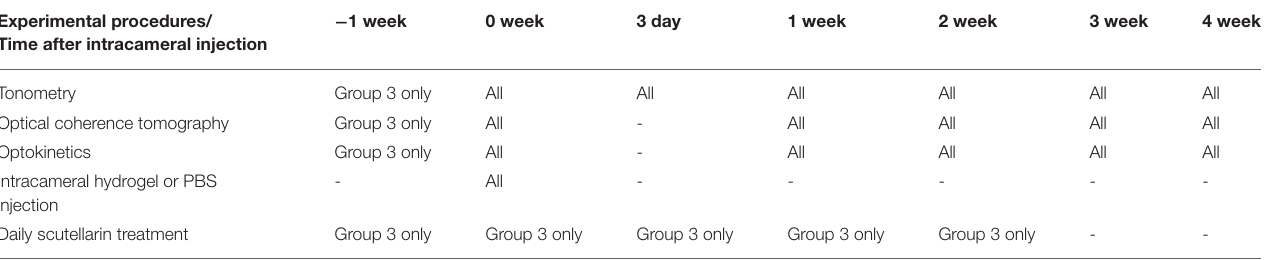
TABLE 1 | Overall experimental